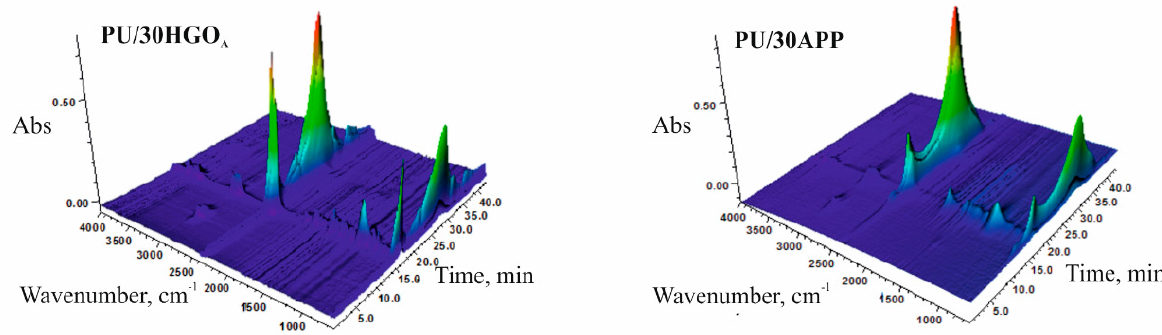
Figure 13. The 3D TGA/FT-IR spectra of PU/30HGO A and PU/30APP. The obtained results indicate two stages of thermal degradation of PU/30HGO A (in 16.01 and 27.97 min) and three stages of thermal degradation PU/30APP (in 15.98, 27.17, and 37.13 min). Peaks observed in the first stage of material degradation, in the range of 4000–3500 cm − 1 , are related to the O-H stretching vibrations from water as well as N-H stretching vibrations. Signals observed in the range 3020–2820 cm − 1 are connected to the C-H stretching vibrations from CH 2 groups. In turn, peaks at 2358, 2322, and 668 cm − 1 are related to CO 2 , which is a product of urethane groups decomposition. Moreover, low in- tensity peaks at wavenumbers 2181 and 2099 cm − 1 , related to CO, were observed. The peak at 1507 cm − 1 is due to the stretching vibrations of the aromatic ring formed upon pyrolysis. The peak at 1456 cm − 1 was assigned to the -CH 2 - bending vibrations. The further peaks located at 1751 and 1116 cm − 1 are related to the C=O and C–O–C groups, respectively [42,43]. For the PU/30APP material, additional signals were observed at the values of 966 and 930 cm − 1 , which can be assigned to the presence of NH 3 . In the second stage of material degradation, signals related to CO 2 and CO release for both materials were observed. For the PU/30APP material, the third degradation stage was observed accompanied by CO 2 and CO release. The observed pathways of thermal degradation may result from the for- mation of char, acting as an effective physical barrier limiting the release of pyrolysis products in the case of both materials. However, observed degradation course suggests that the char formed in the pyrolysis of PU/30APP undergoes further decomposition in the third stage, differently from the PU/30HGO A . This conclusion is corroborated by the higher share of carbon in the combustion residue of PU/30HGO A (Figure 9).